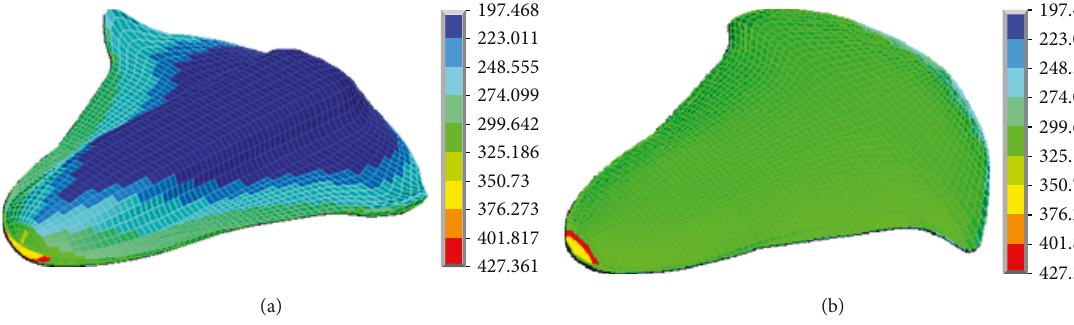
Figure 9: Temperature distribution (K) on the interior wall of the discretized thermal protection system surface T